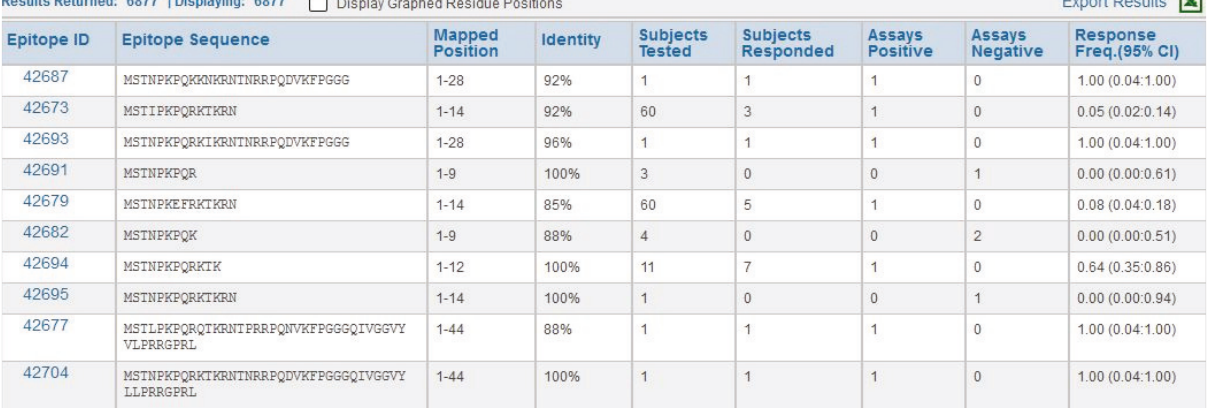
Figure 5: The Immunome Browser generates a table that lists all epitopes and corresponding response information sorted by their mapped position. This table can be downloaded in a CSV-formatted fi le by clicking on the “ Export Results ” link in the upper right